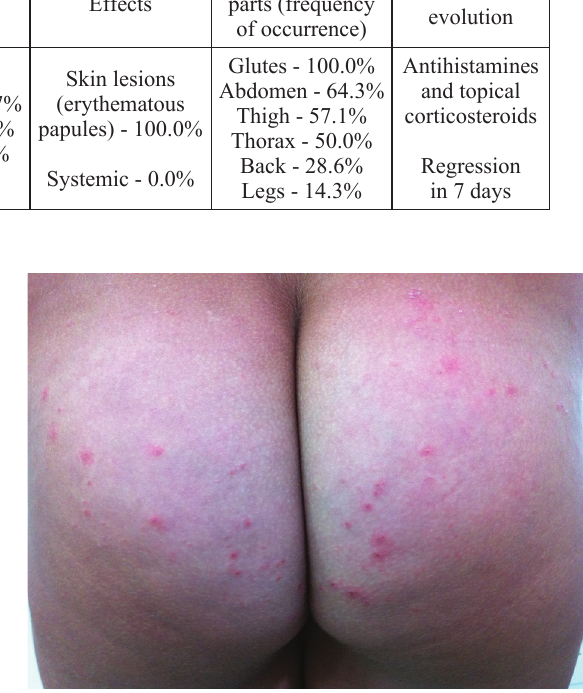
Figure 2 - Female child, habitual frequenter of Camboriú Beach (SC) with discrete erythematous papules located in the gluteal region seven days after the